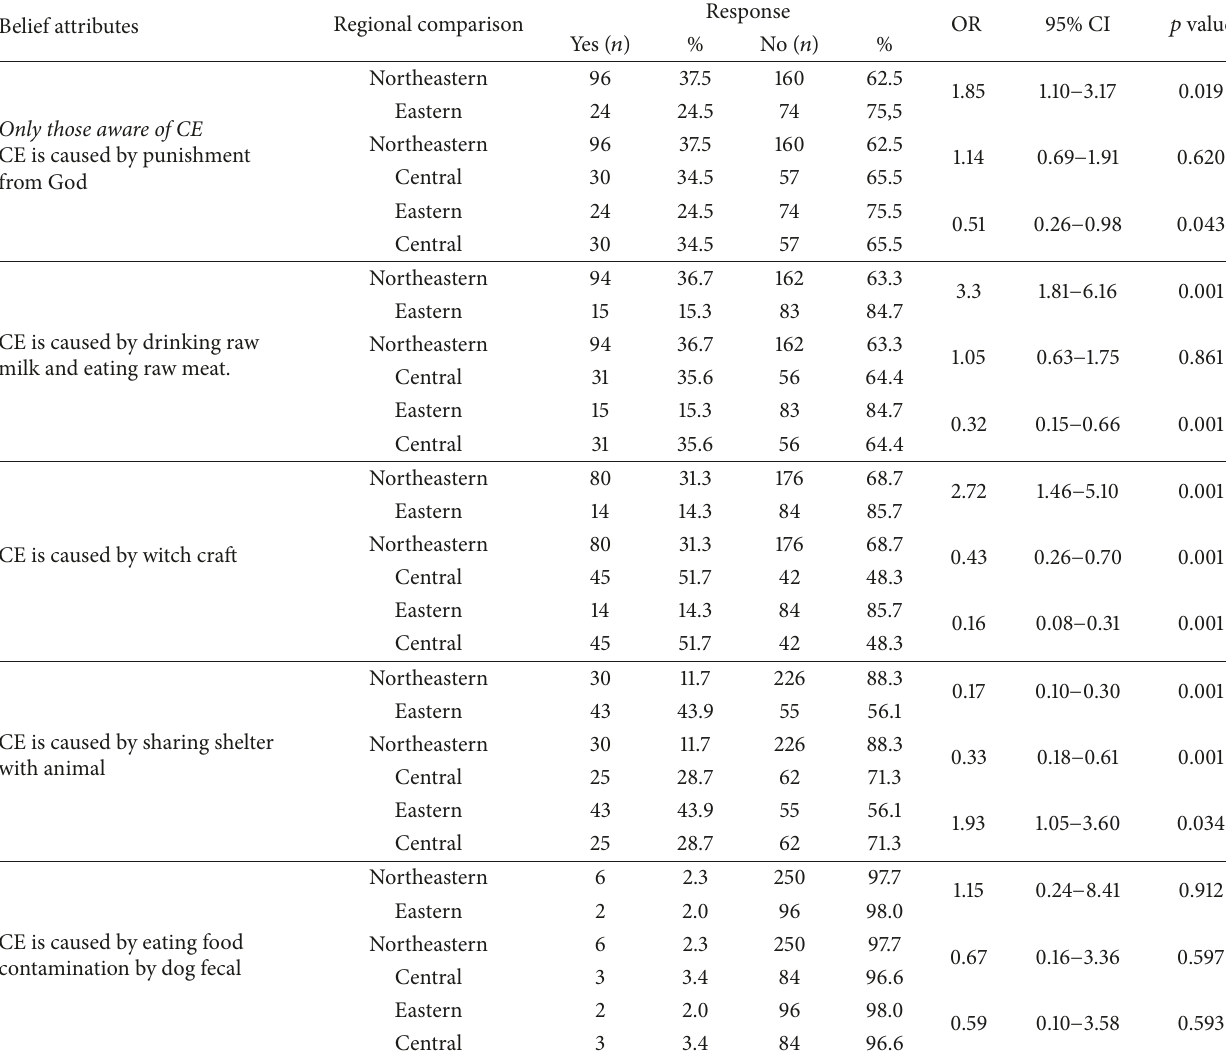
Table 6: Beliefs of the communities about cystic